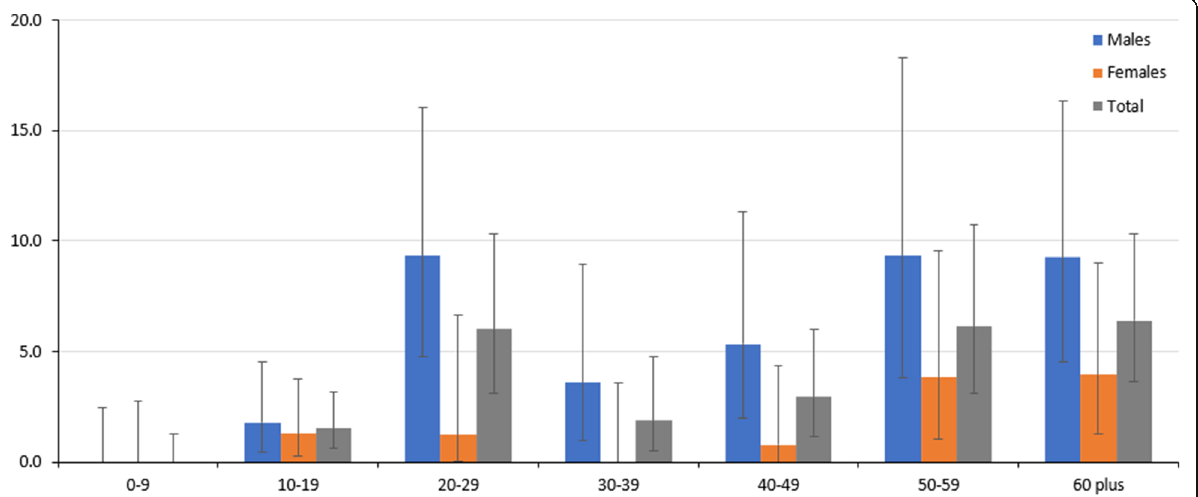
Fig. 4 Percentage of positive cases (ICT) by age and gender, Niue 1999. Y -axis, percentage positive (95% confidence interval); X -axis, age group. Source: Adapted from [22]. Error bars represent binomial 95% confidence